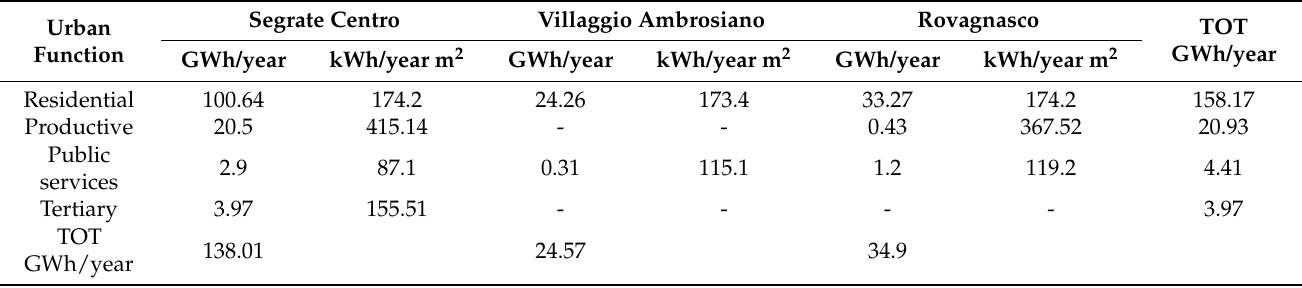
Table 3. Energy consumption in the different urban functions presented in the case study’s